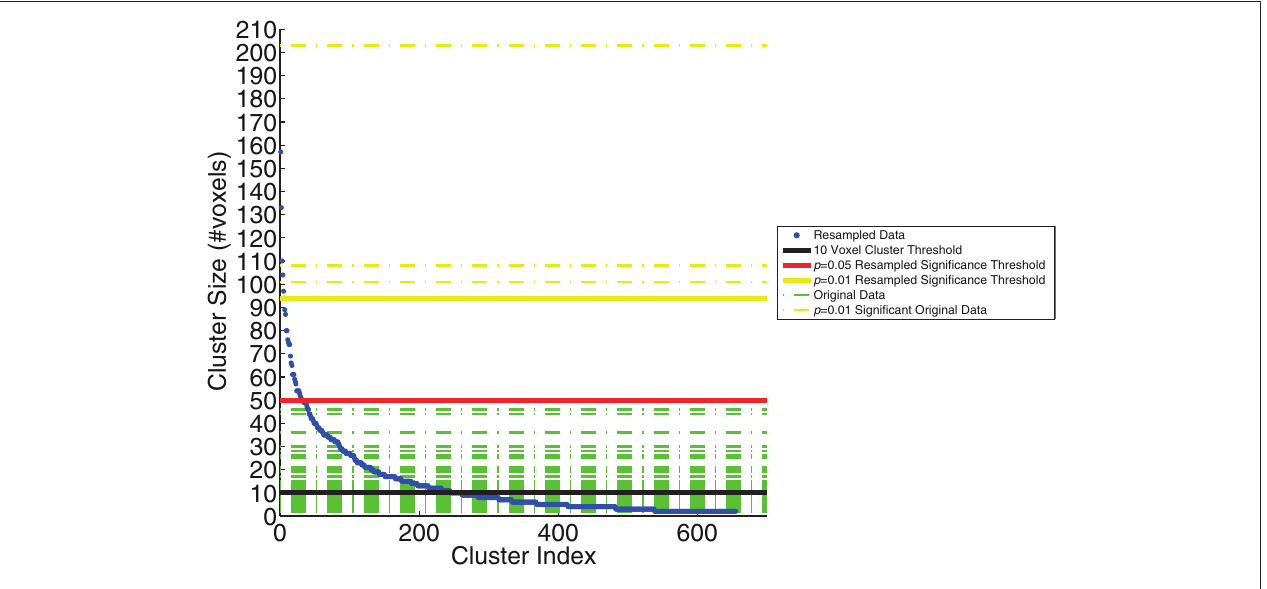
FIGuRE 3 | The resampling method, used to generate the threshold based on cluster size. The resampled data (blue) are sorted and plotted in increasing cluster size (number of voxels). Three significance thresholds are presented: 10 voxel canonical cluster threshold (black solid line), p = 0.05 resampled significance